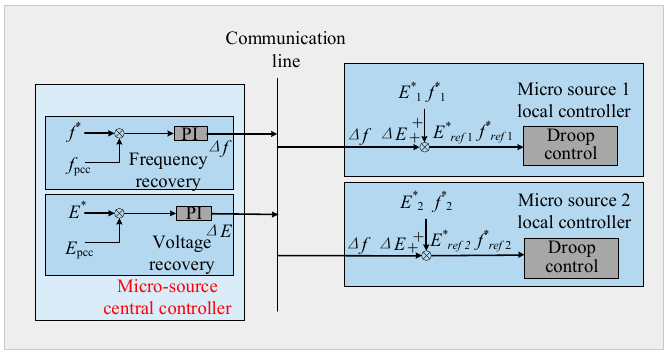
Figure 2. The block diagram of secondary control strategy.